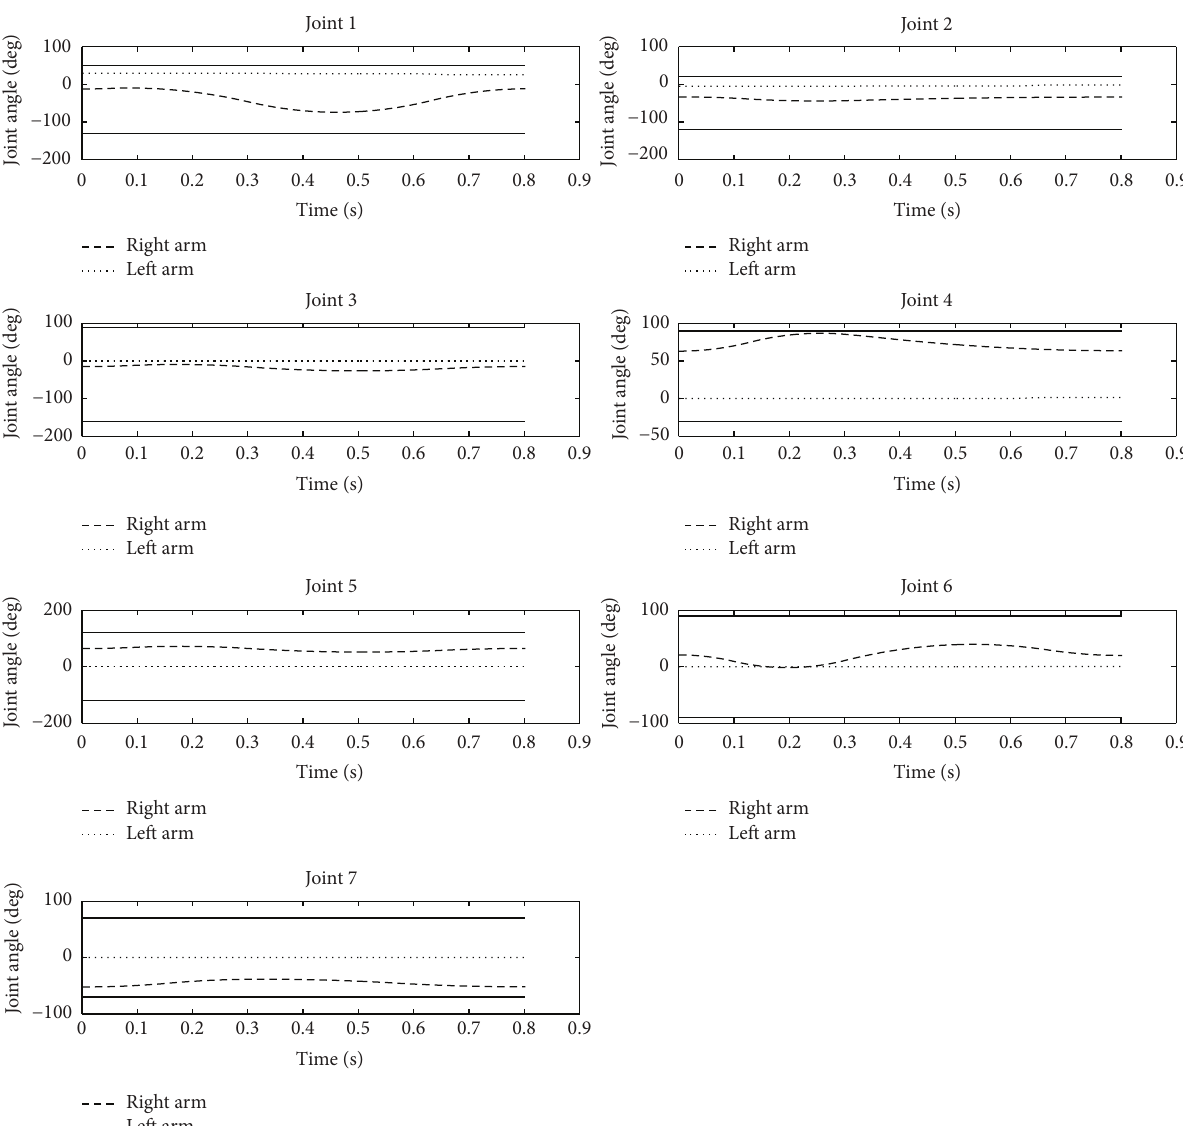
Figure 7: Joint angular curve of the robot’s